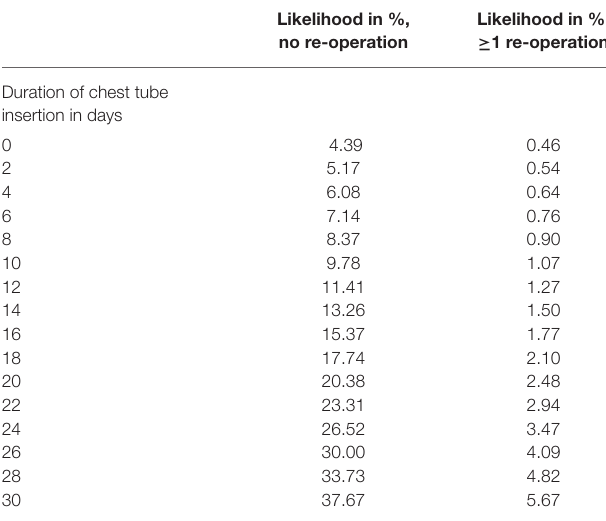
TABLE 11 | Independent predictors of adhesive small bowel obstruction (ASBO) using multivariate analysis. OR (95% CI) p -value